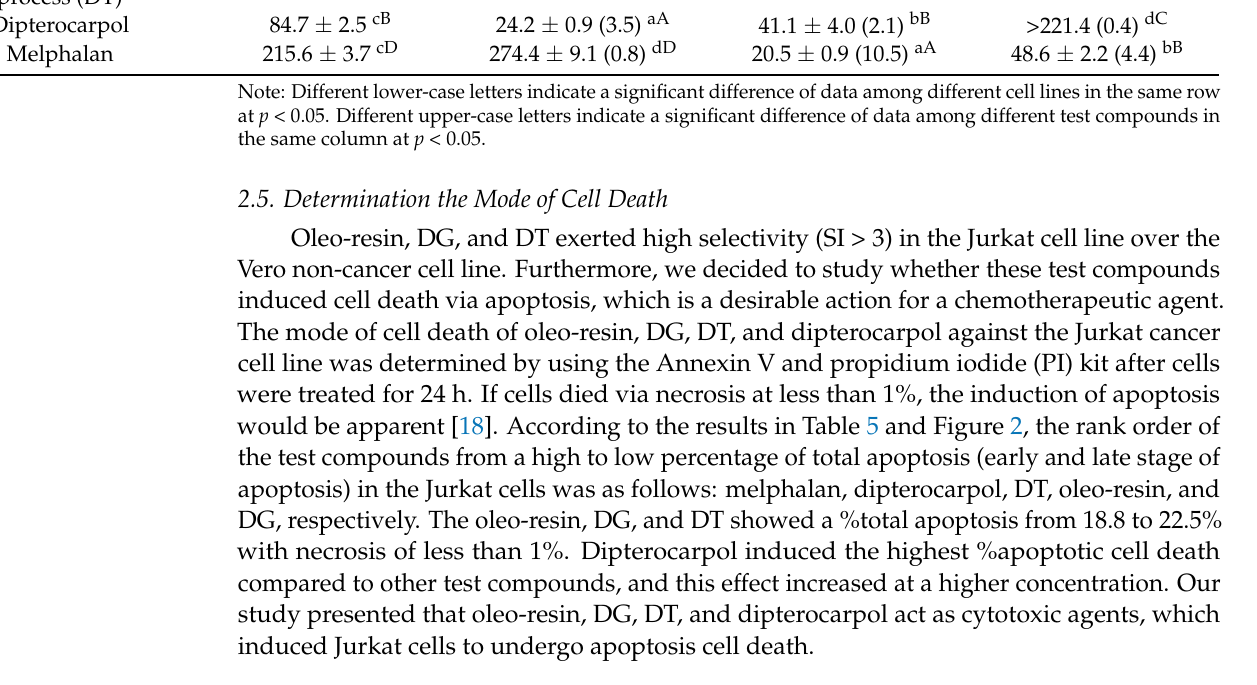
Table 5. Mode of cell death of oleo-resin, resin from different preparation processes and dipterocarpol at 1 × IC 50 and 2 × IC 50 concentrations against Jurkat cancer cells at 24